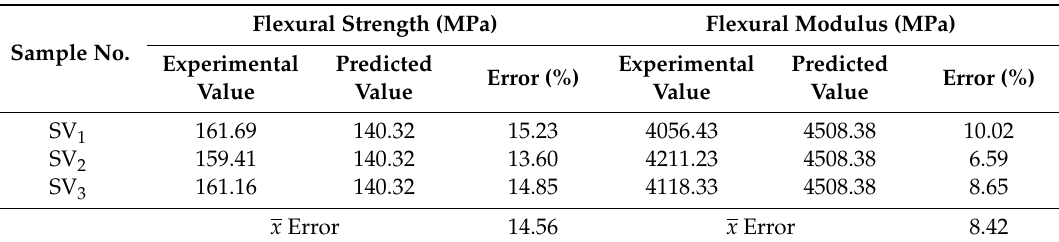
Table 9. Experimental validation for flexural strength and flexural modulus.